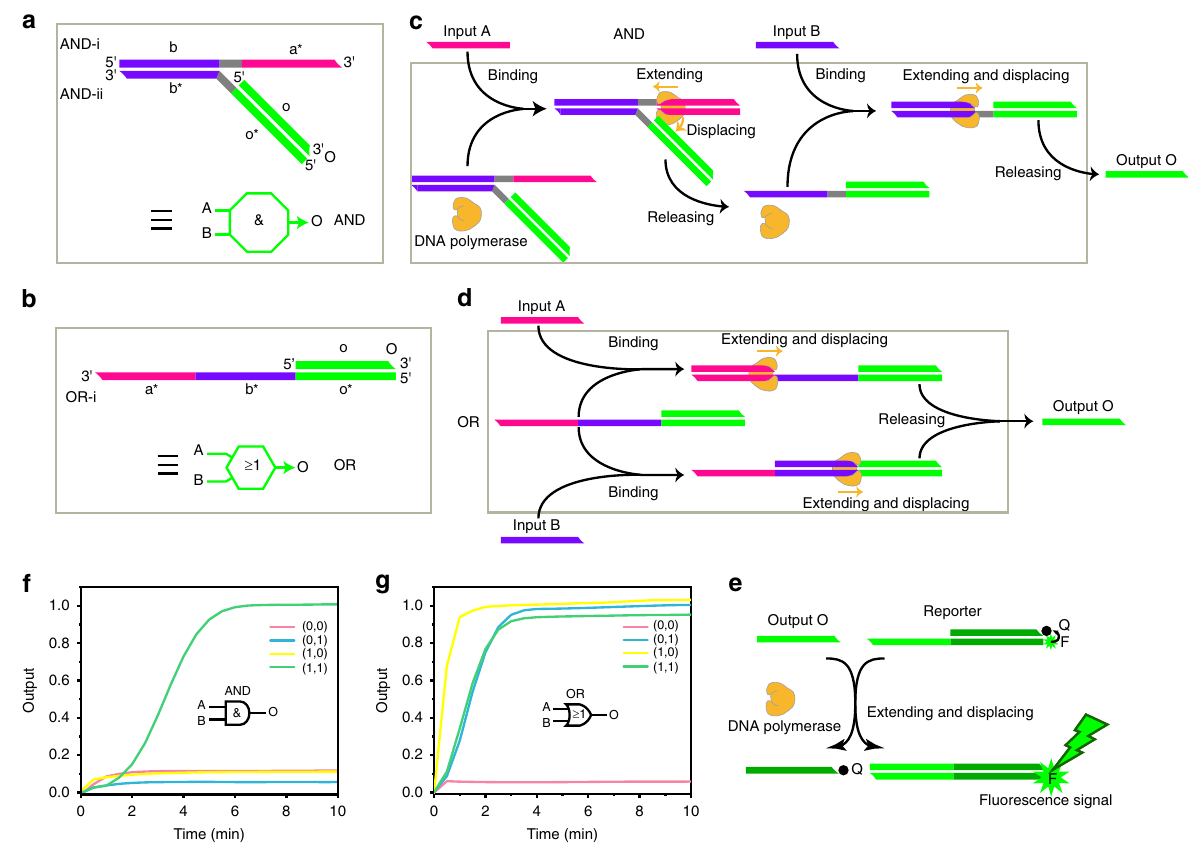
Fig. 1 Construction of AND and OR gates with DNA polymerase and their performance. a , c Right: structure of the AND and OR gates. The capital names are the sequence names; the lowercase names refer to the elementary sequences and asterisk indicates a complementary sequence. Each elementary sequence contains 18 bases. The gray parts are 4-mer spacer sequences used to reduce steric hinderance. The sequences of inputs A and B are the same as a and b. Left: abstract diagram of the AND and OR gates. The regular octagon shows the main structure of the DNA components; the two bold lines on the left indicate the binding sites of the two inputs in the DNA component; the vector line on the right indicates the potential output. b , d Mechanism of the AND and OR gates. e The fl uorescent reporter used to visualize the devices. The letter Q denotes the quencher, and F denotes the fl uorophore. f , g Reaction kinetics of the AND and OR gates with all possible combinations of inputs. The reaction was performed with 3.2 U Bst polymerase (large fragment) and TRI at 35 °C. The curve was plotted by transferring the cycle value into the reaction time. The outputs were normalized to the relative fl uorescence unit (RFU) values in the FAM channel with the highest signals. The original signals are plotted in Supplementary Fig. 3. The sequences of the DNA strands are listed in the Supplementary Table